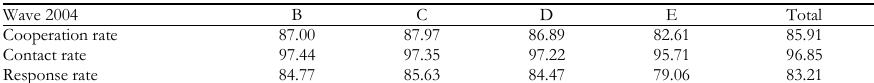
EU-SILC cross-sectional and longitudinal samples: synthetic quality indicators – wave